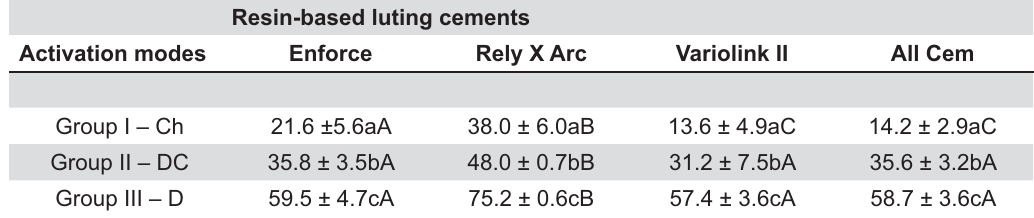
TABLE 1- Mean values and standard deviations of the